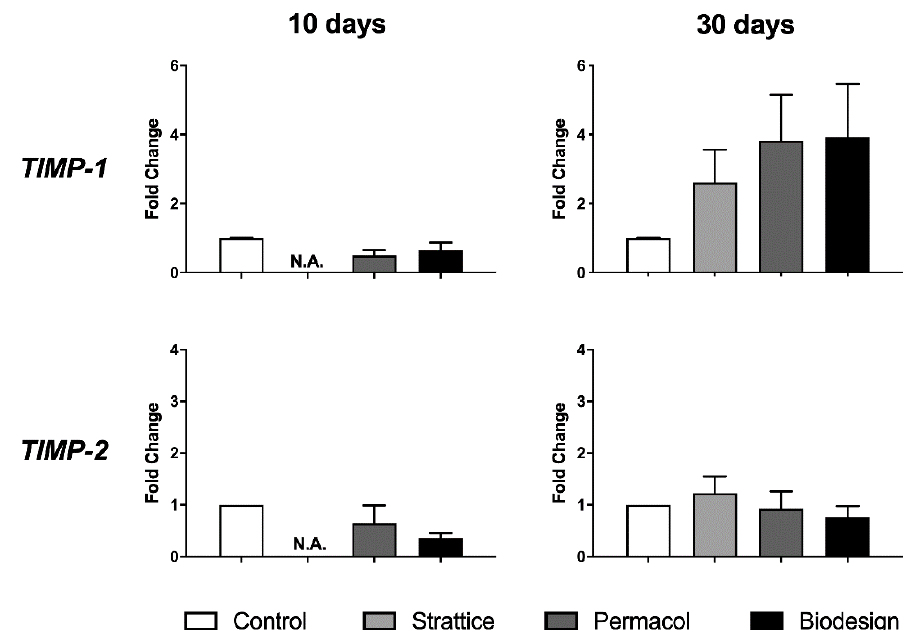
Figure 5. Changes in the transcript levels of metalloproteinase inhibitors following growth on the different types of matrices for 10 or 30 days compared to the control condition — expression from fibroblasts grown on plastics (control), Strattice, Permacol, and Biodesign. Values are the means of four independent experiments ± SE. The results were analyzed with ANOVA. N.A. indicates that the sample was not analyzed since the amount of RNA extracted from the sample was not sufficient to analyze all genes of